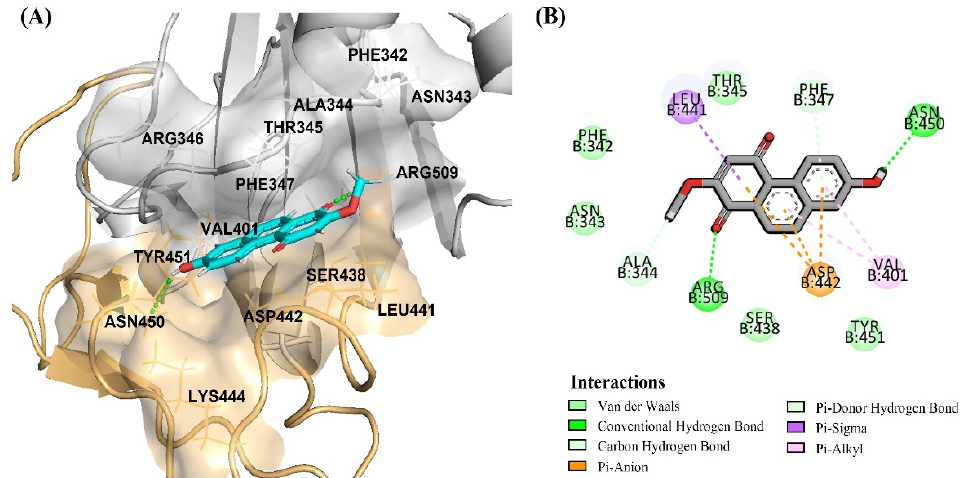
Figure 9. Binding modes of DB31 located in the S1-RBD of the spike protein adjacent to the binding motif (RBM) region in an orange color surface: ( A ) surface view of DB31 binding position between RBM (orange color) and RBD (gray color) regions; ( B ) amino acid interactions of DB31.